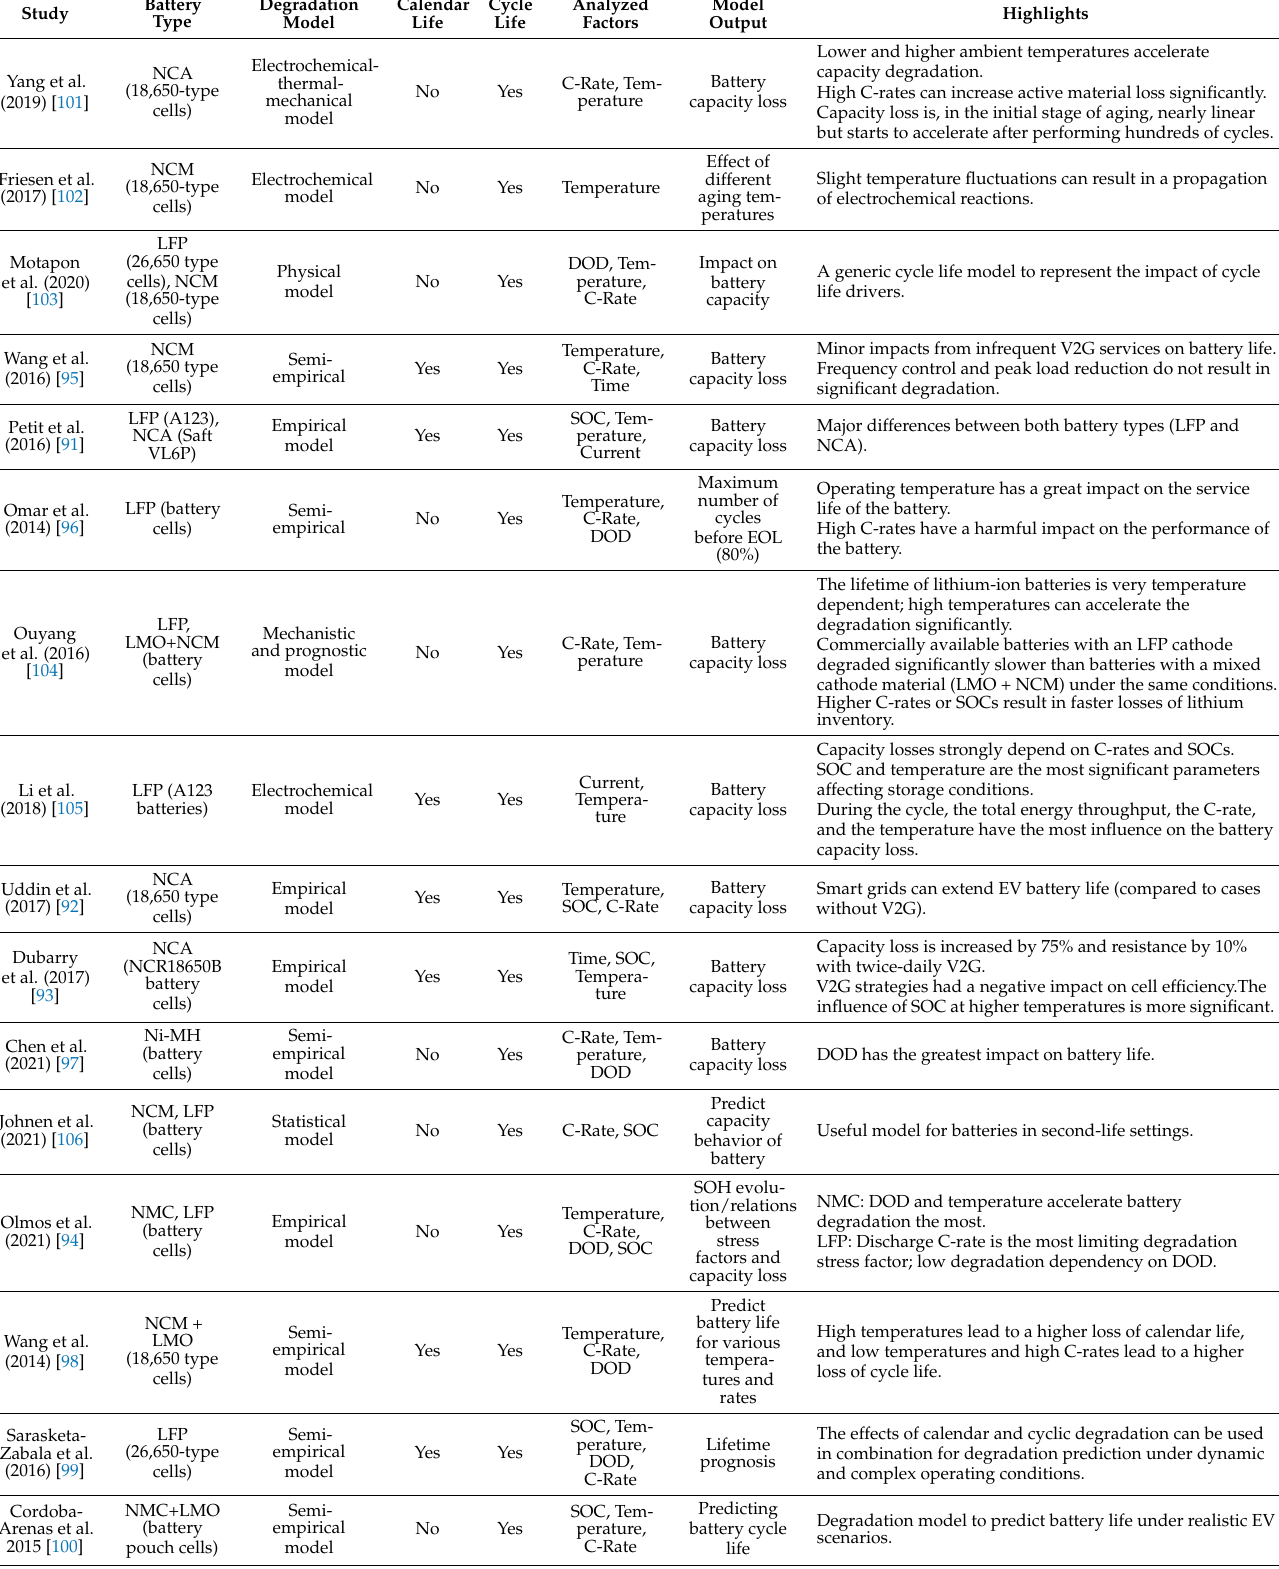
Table 2. Battery degradation